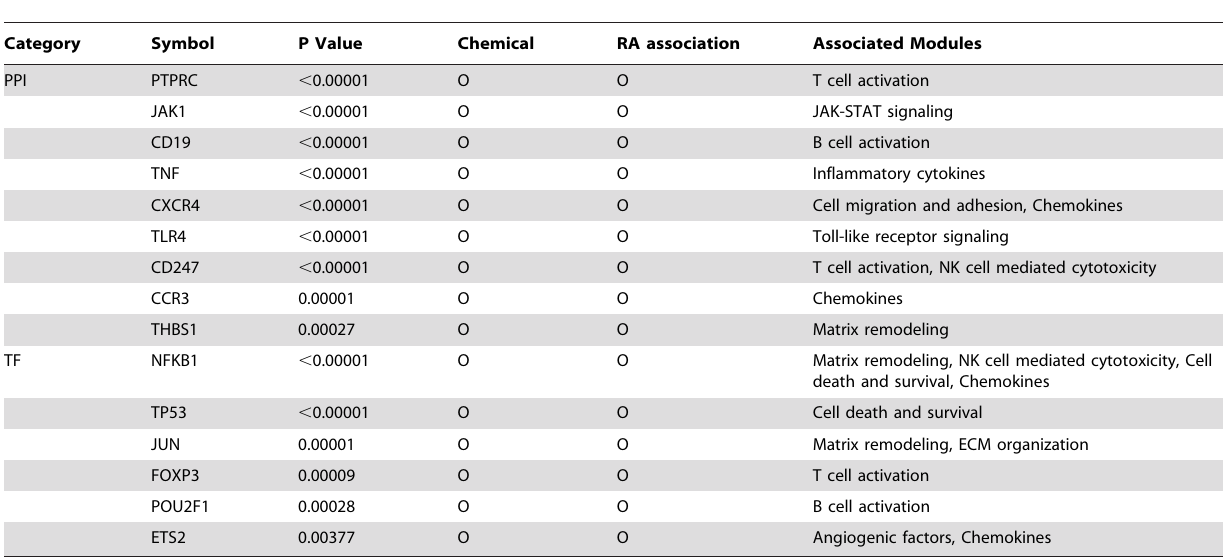
Table 2. Known molecular target candidates for diagnosis and therapy of RA.